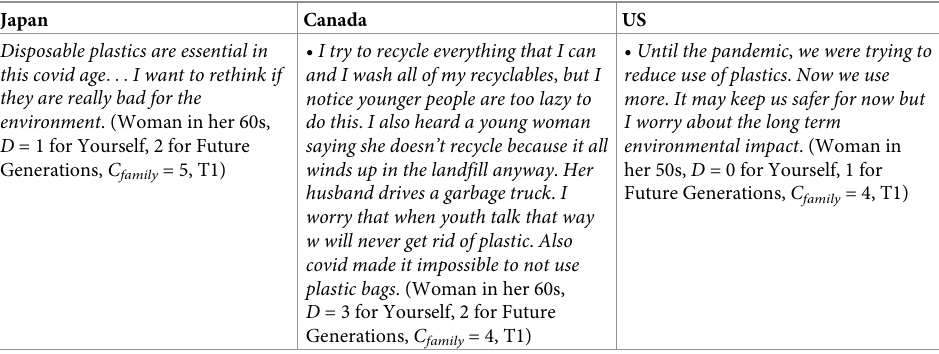
• I try to recycle everything that I can and I wash all of my recyclables , but I